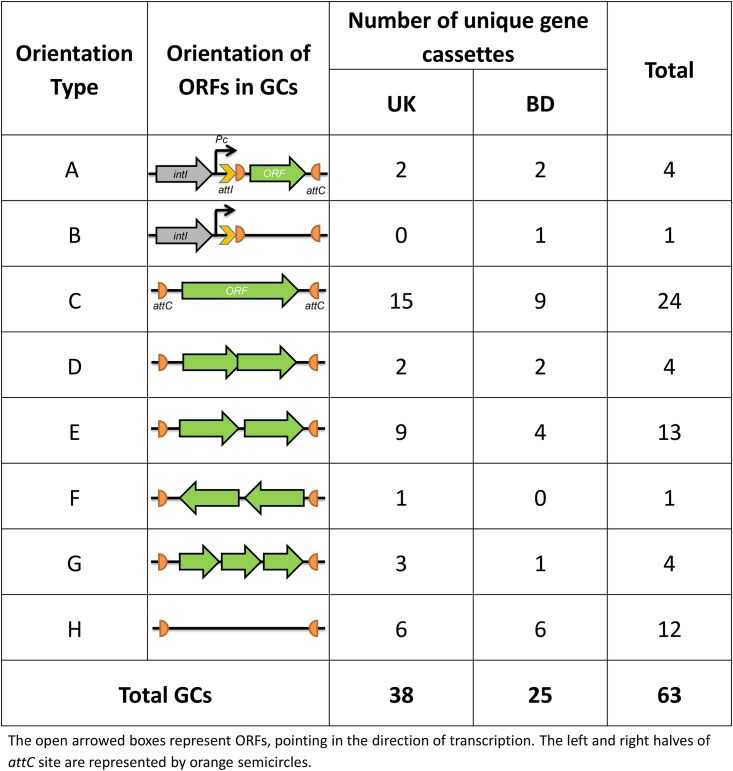
Orientation of ORFs in the GCs recovered from metagenomic DNA of saliva samples.